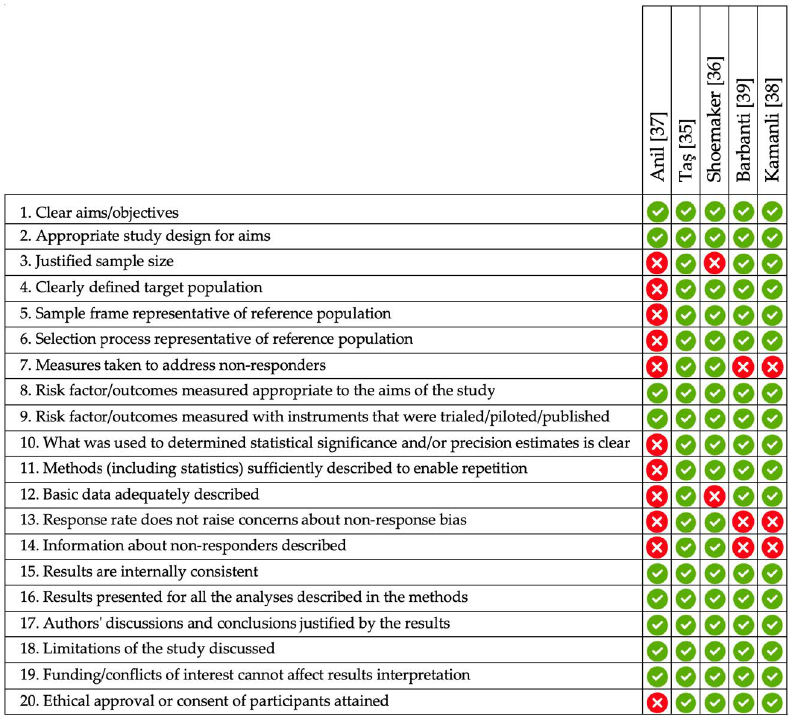
Figure 4. A summary of the quality assessment of the included cross-sectional studies using the AXIS [31] tool.